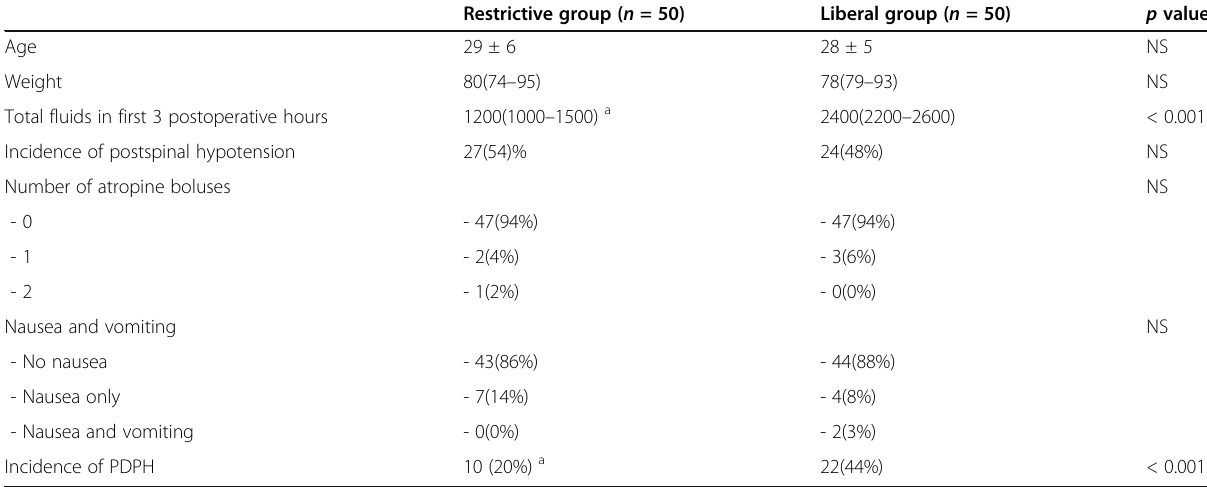
Table 1 Demographic data and patient outcomes